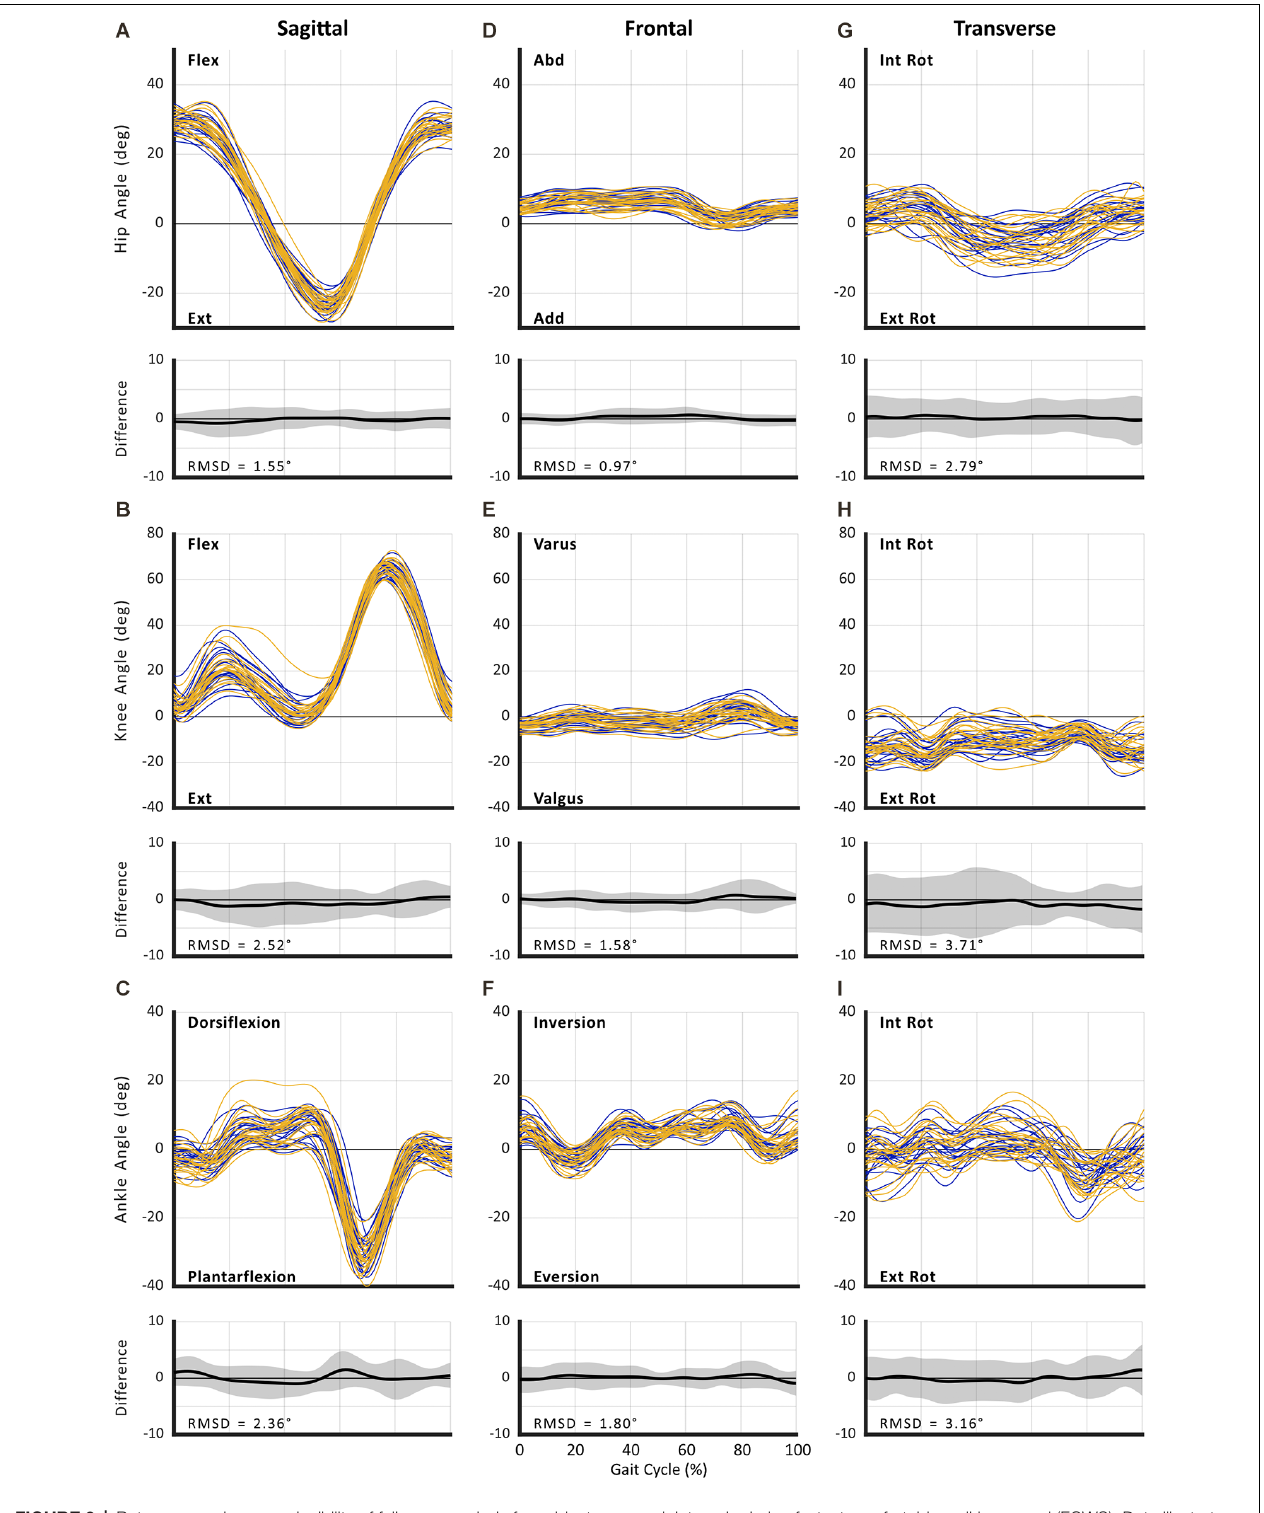
FIGURE 3 | Between-session reproducibility of full curve analysis for subject-average joint angle during fastest comfortable walking speed (FCWS). Data illustrate joint angles for hip (row 1), knee (row 2), and ankle (row 3) in the sagittal (A–C) , frontal (D–F) , and transverse planes (G–I) . Each curve represents the ensemble average of each individual’s trials for Session 1 (blue lines) and Session 2 (gold lines). The average RMS difference across all subjects is shown below the respective joint angle plot; across all joints and planes of motion, the largest RMSD was 3.56 ◦ .